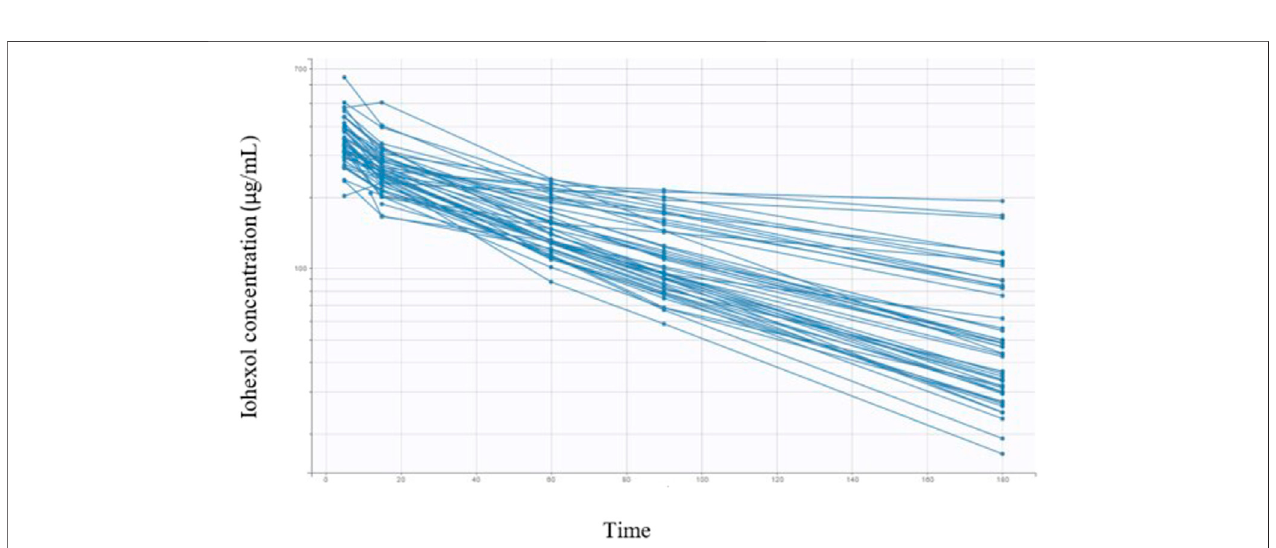
FIGURE 1 | Semi-logarithmic spaghetti plots of iohexol plasma concentrations over 180 min after a single i.v. administration (nominal dose of 64.7 mg/kg) in 49 dogs.